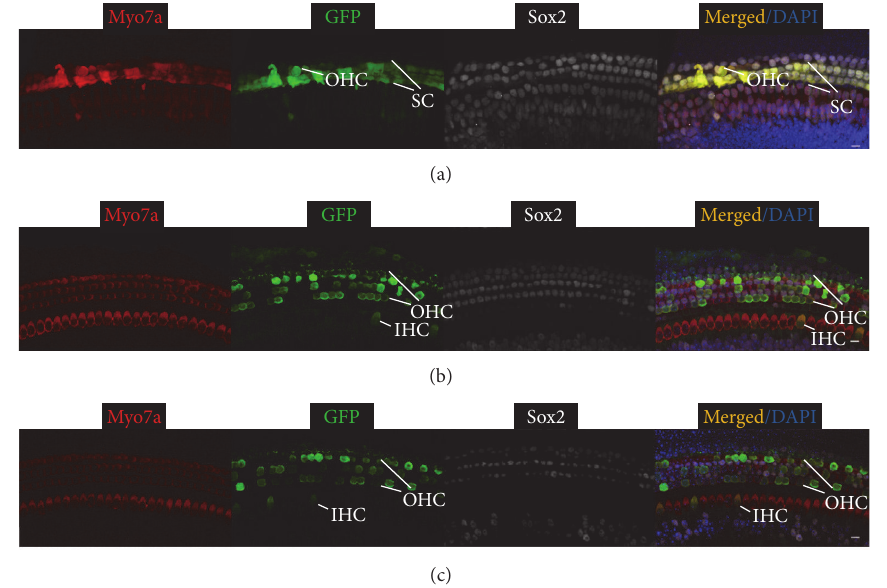
Figure 3: Ad-GFP-VB transduces diverse cell types in mouse cochlea when injected at P0. Representative confocal images of whole-mount fluorescent immunolabeling of the cochlea injected with adenovirus at P0 to illustrate the basal (a), middle (b), and apical turns (c). Ad-GFP- VB transduces SCs and OHCs at basal (a), OHCs, IHCs, and SCs at middle (b), and OHCs and IHCs at apical turns (c). IHC: inner hair cell, OHC: outer hair cell, and SC: supporting cell. Scale bars: 10 𝜇